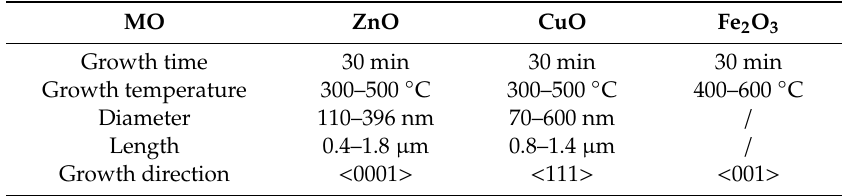
Table 1. Characteristics of the zinc oxide, copper oxide, and iron oxide nanostructures produced in this work.